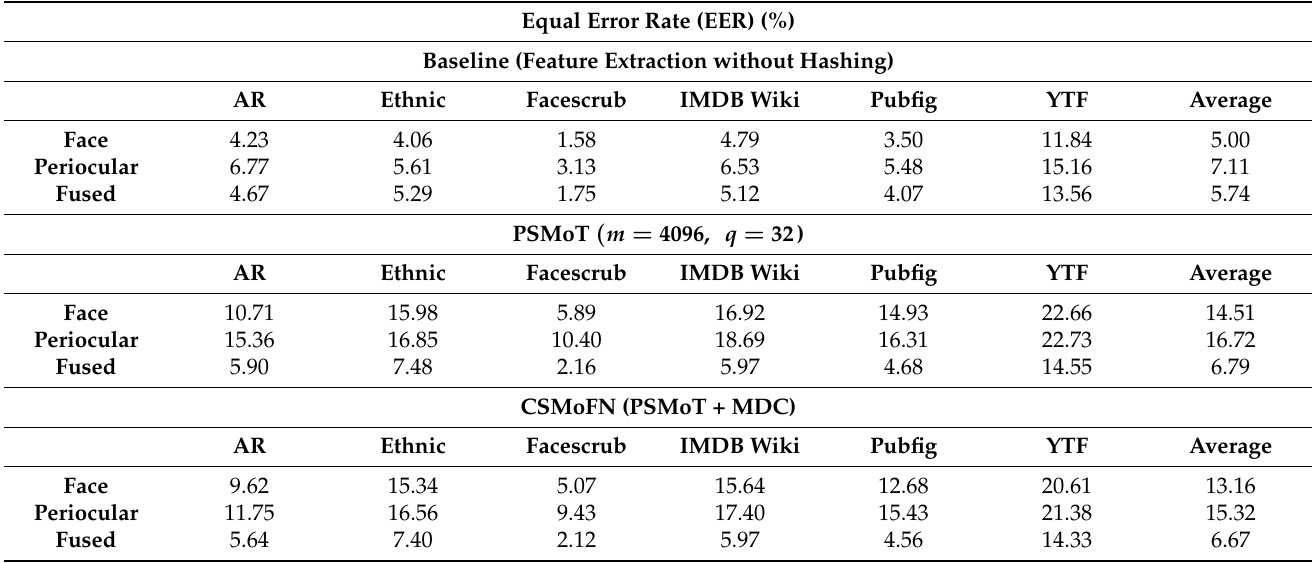
Table 6. Ablation study for each module (baseline, PSMoT, and CSMoFN).